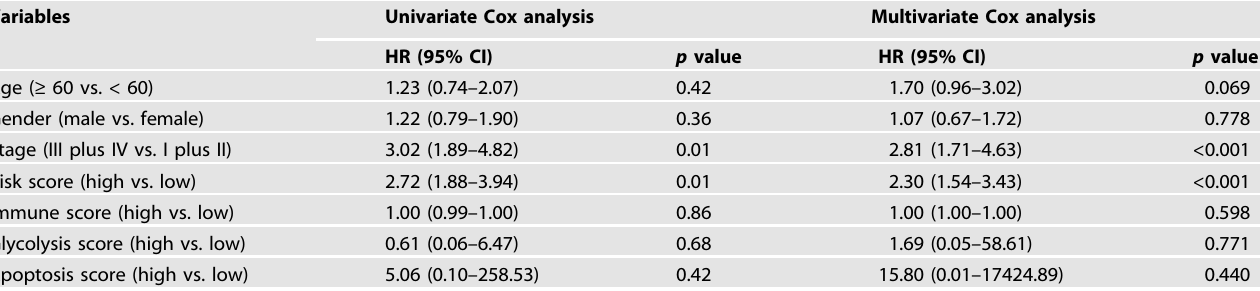
Table 1. Univariate and multivariate Cox regression analyses for overall survival of patients with colon cancer from TCGA database based on risk score constructed by SLC25.